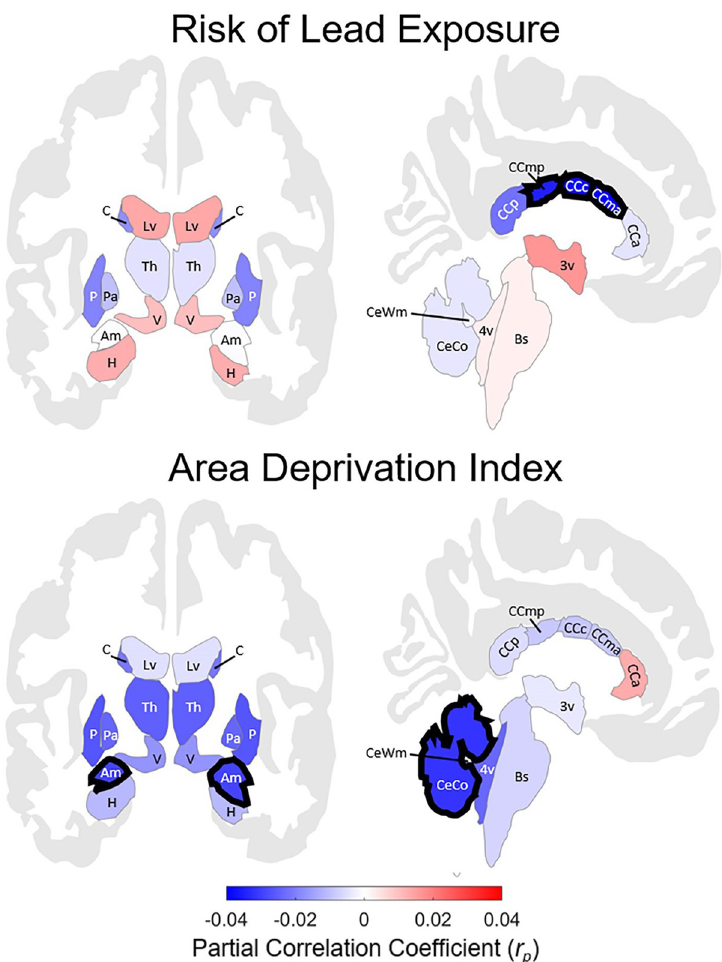
Fig 2. Regional associations between subcortical volume and risk of lead exposure (top) or area deprivation index (ADI) (bottom). For lead risk, these associations, correcting for false-discovery rate (FDR), were significant for mid- posterior, central, and mid-anterior corpus callosum. For ADI, subcortical gray matter, cerebellum cortex, accumbens area (not shown in this image), and amygdala. Regions are color-coded in correspondence to the effect size (i.e., partial correlation coefficient) of lead risk (top) and ADI (bottom), controlling for age, sex, parental education, race, ethnicity, family income, intracranial volume, and the interaction between family income and either lead risk or ADI. Regions with bolded outlines passed FDR correction. Blue-shaded regions indicate inverse associations between lead risk (or ADI) and volume (e.g., greater lead risk, lesser volume), while red-shaded regions indicate positive correlations (e.g., greater lead risk, greater volume). These images were generated in MATLAB using data from the ggseg toolbox in R [57]. 3v = 3 rd ventricle; 4v = 4 th ventricle; Am = amygdala; Bs = brain stem; C = caudate; CCa = anterior corpus callosum; CCc = central corpus callosum; CCma = mid-anterior corpus callosum; CCmp = mid-posterior corpus callosum; CCp = posterior corpus callosum; CeCo = cerebellum cortex; CeWm = cerebellum white matter; H = hippocampus; Lv = lateral ventricle; Pa = pallidum; P = putamen; Th = thalamus; V = ventral diencephalon. associations between lead risk and mid-anterior ( r = -0.036 [-0.047, -0.025]), central ( r = p p -0.034 [-0.045, -0.023]), and mid-posterior corpus callosal volumes ( r = -0.030 [-0.040, p -0.019]) were maintained ( q < .05), as were the FDR-corrected associations between ADI and subcortical gray-matter ( r = -0.034 [-0.045, -0.023]), amygdalar ( r = -0.033 [-0.043, -0.022]), p p